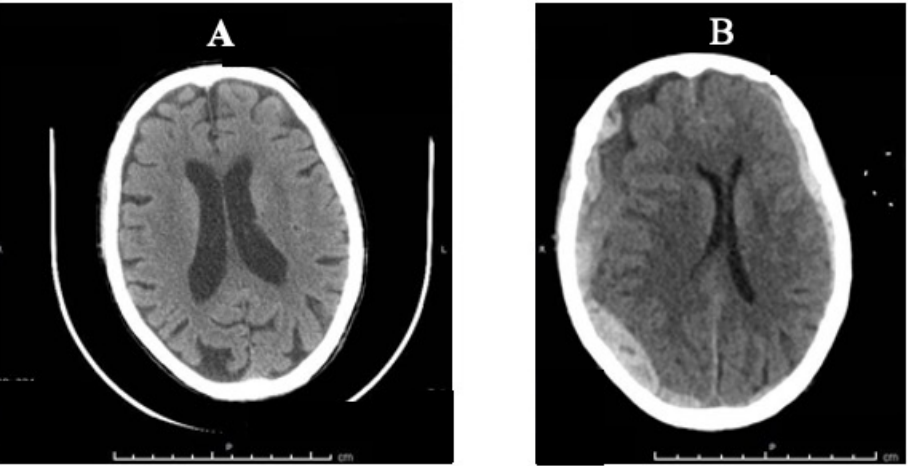
Figure 1. CT-scan comparison: ( A ) Two-month-old CT scan with signs of chronic ischemic encephalopathy and enlargement of intracranial cerebrospinal fluid spaces; ( B ) CT-scan made in the hospital showing bilateral SDH.